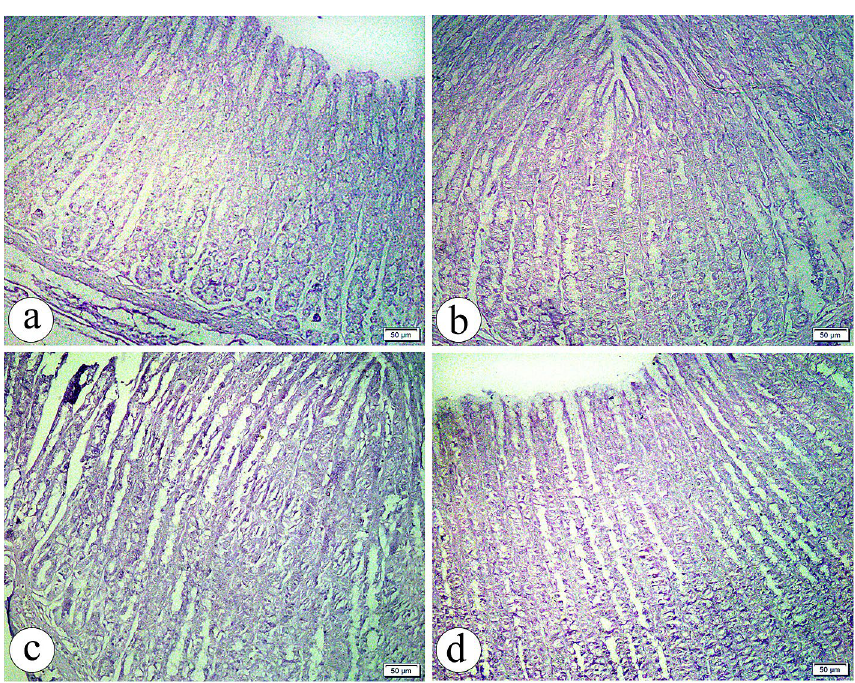
Figure 6. The photomicrographs of the sections in the glandular portion of the stomach in ( a, b, c, d ) showing a negative EGFR immunoexpression in all studied groups; Ӏ , ӀӀ , ӀӀӀ , Ӏ V, receptively. (EGFR immunohistochemical staining × 200, Scale bar = 50